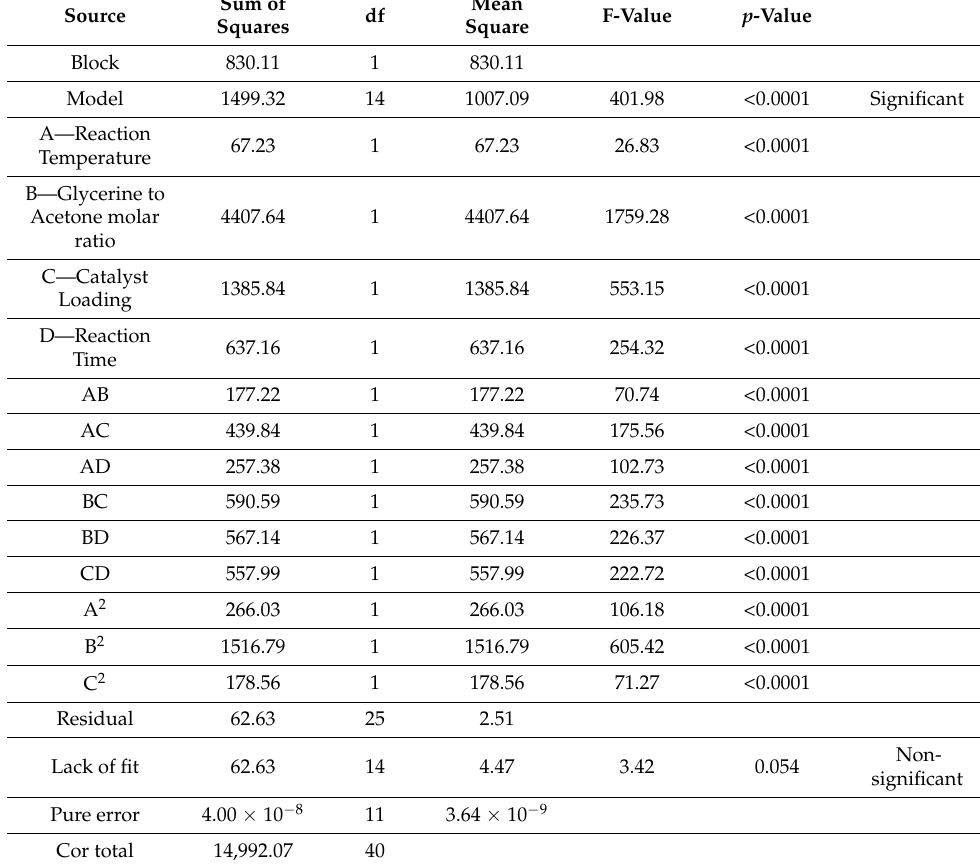
Table 7. ANOVA optimization for the acetalization of glycerol for solketal yield.